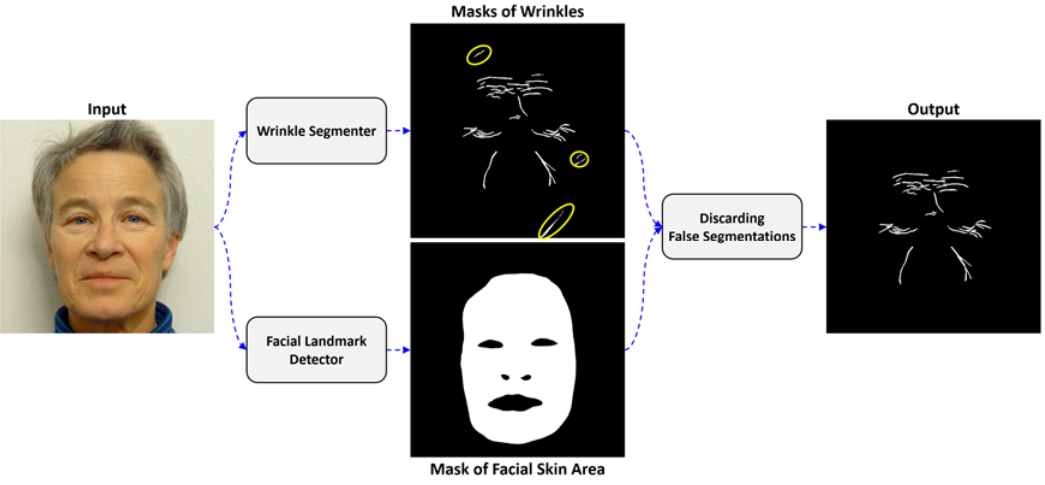
Figure 10. Example of discarding false